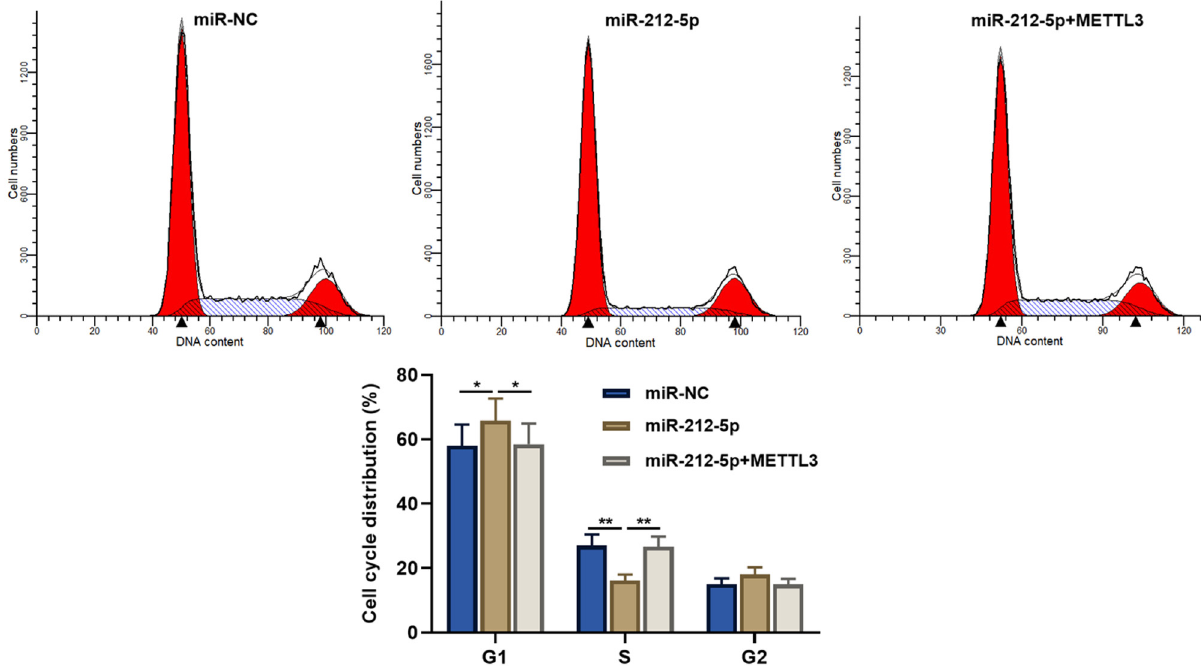
Figure A1: Flow cytometry assay was used to detect the e ff ects of miR - 212 - 5p and METTLE3 on cell cycle